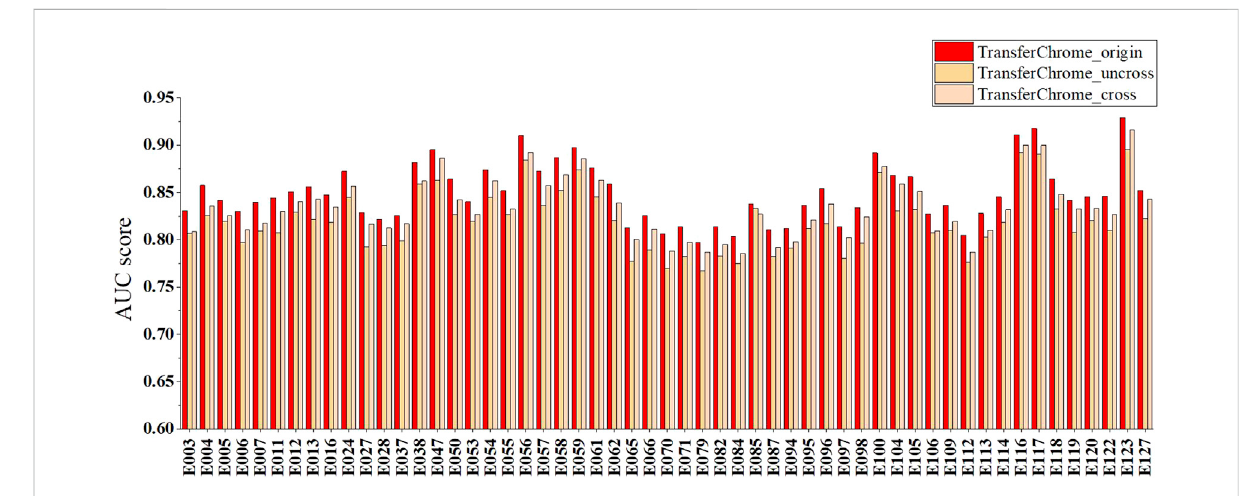
FIGURE 4 The performance comparison of different versions of TransferChrome: TransferChrome_cross, TransferChrome_uncross and